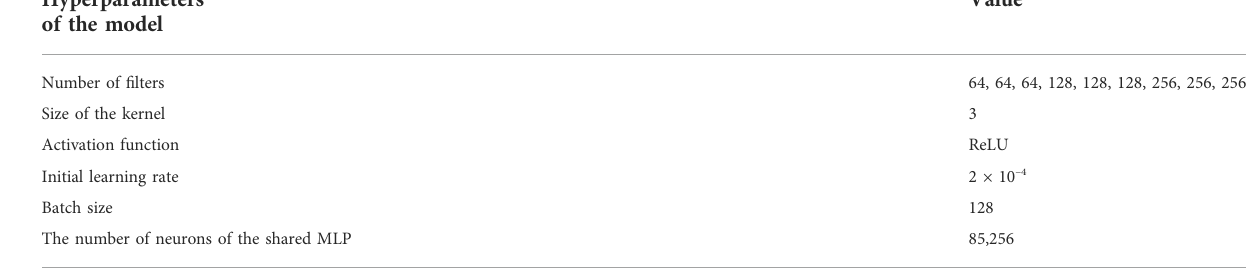
TABLE 1 Hyperparameters of the proposed neural network.